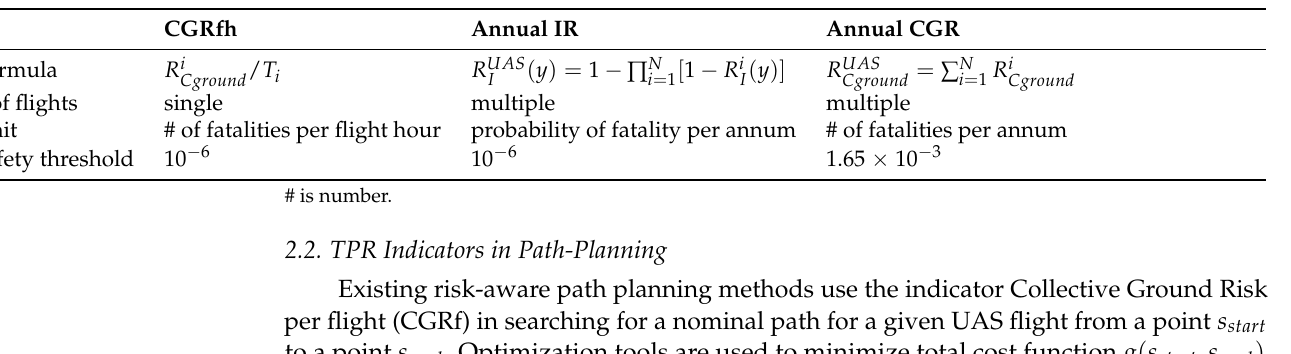
Table 1. Summary for TPR indicators CGRfh, annual IR, and annual